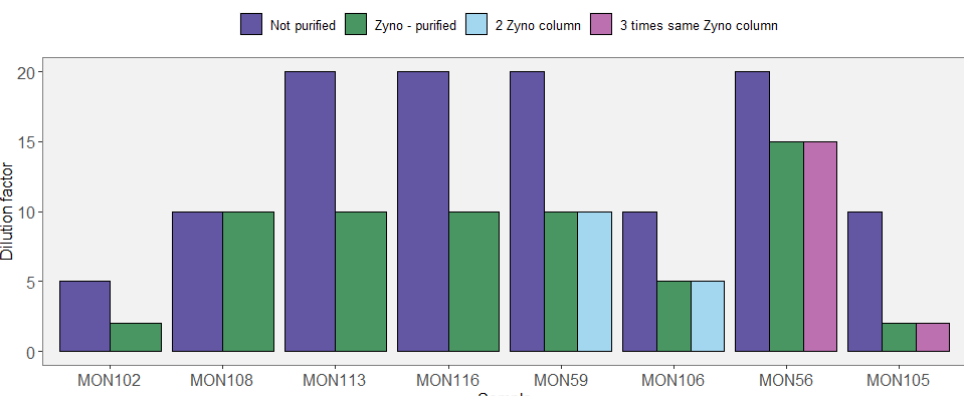
Figure A1. Correlations between ( A ) plant read count and PCR inhibition level ( B ) sediment age and DNA concentration.